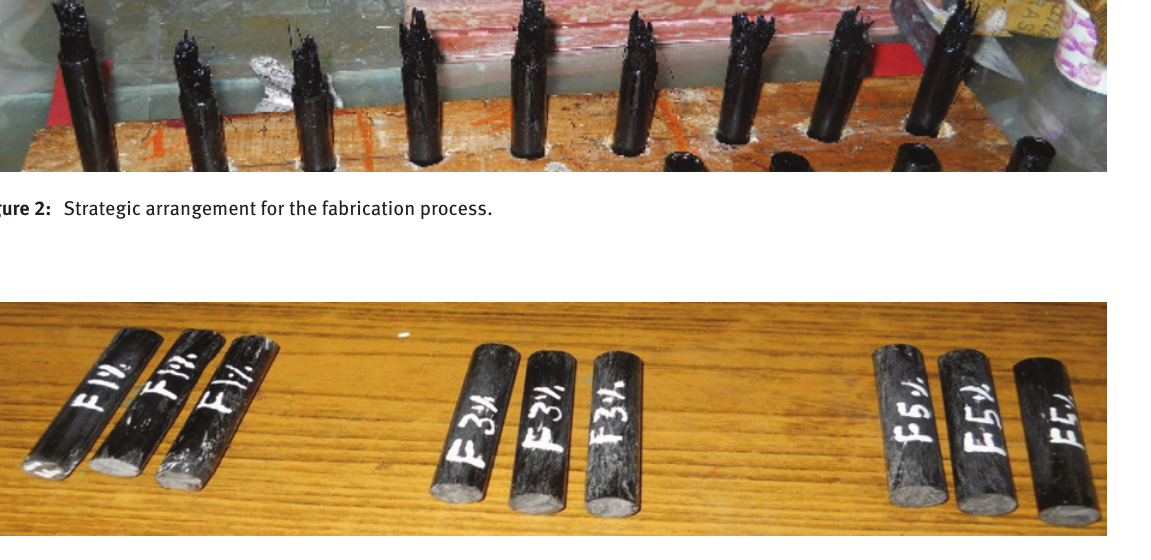
Figure 3: Fabricated hybrid composite samples.